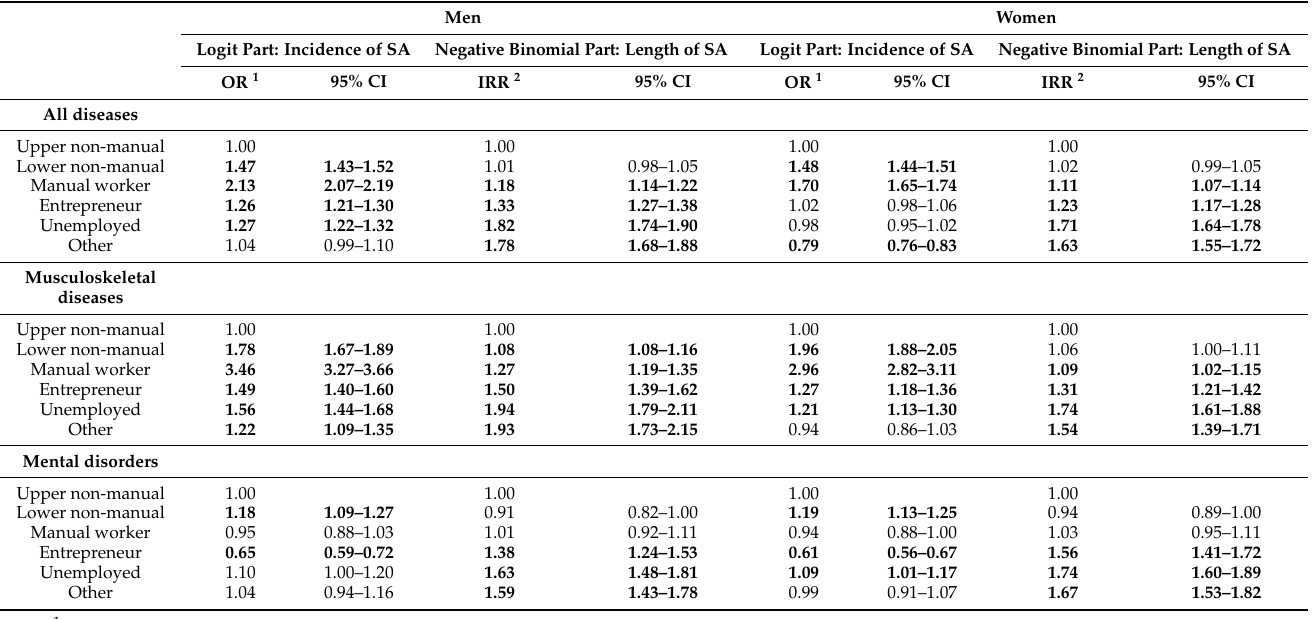
1 Logistic regression part from the ZINB model: analysis of cumulative incidence of sickness absence, calculated as inverted odds ratios to denote the odds of being in the non-zero group. Adjusted for age, marital status, region of residence and income. Estimates in bold are statistically significant using the significance level of p < 0.05. 2 Negative binomial regression part from the ZINB model: analysis of the length of SA, i.e., number of absence days among persons with incident sickness absence. Adjusted for age, marital status, region of residence and income. Estimates in bold are statistically significant using the significance level of p <